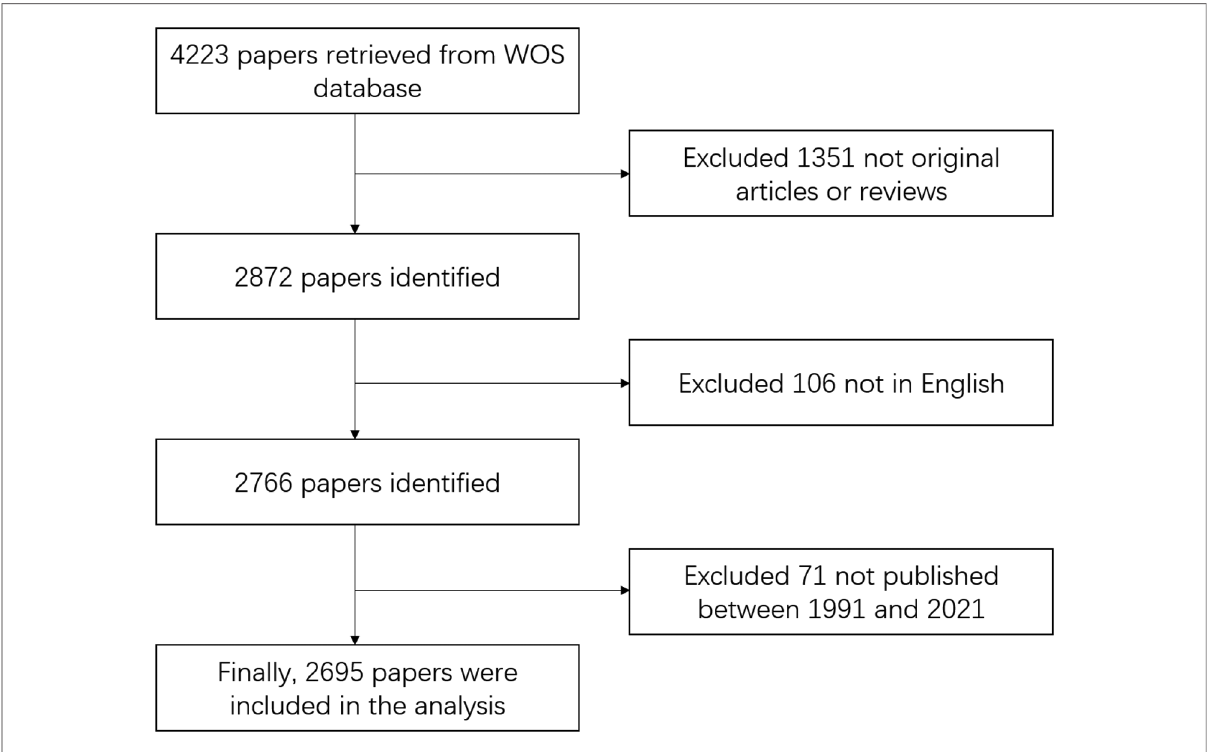
FIGURE 1 Flow chart of the literature screening